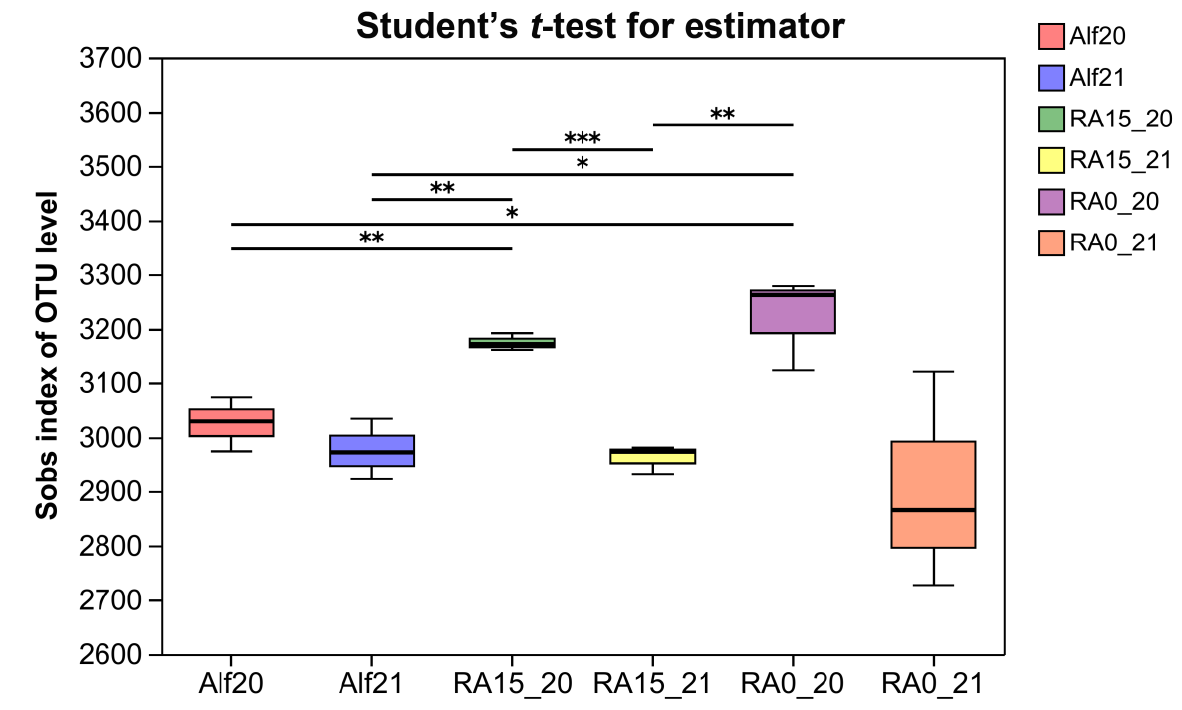
α -diversity (* p < 0.05; ** p < 0.01; *** p < Figure 1. Soil bacterial α - diversity (* P <0.05; ** P <0.01; *** P <0.001). Figure 1. Soil bacterial